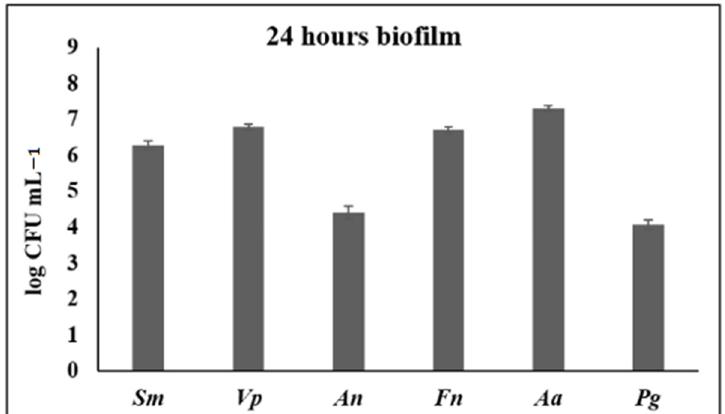
when compared with those without S. downii sp. nov. (Figure 6c,d; live/dead ratio of 1.1 (SD = 0.2) and 1.8 (SD = 0.2), respectively.)